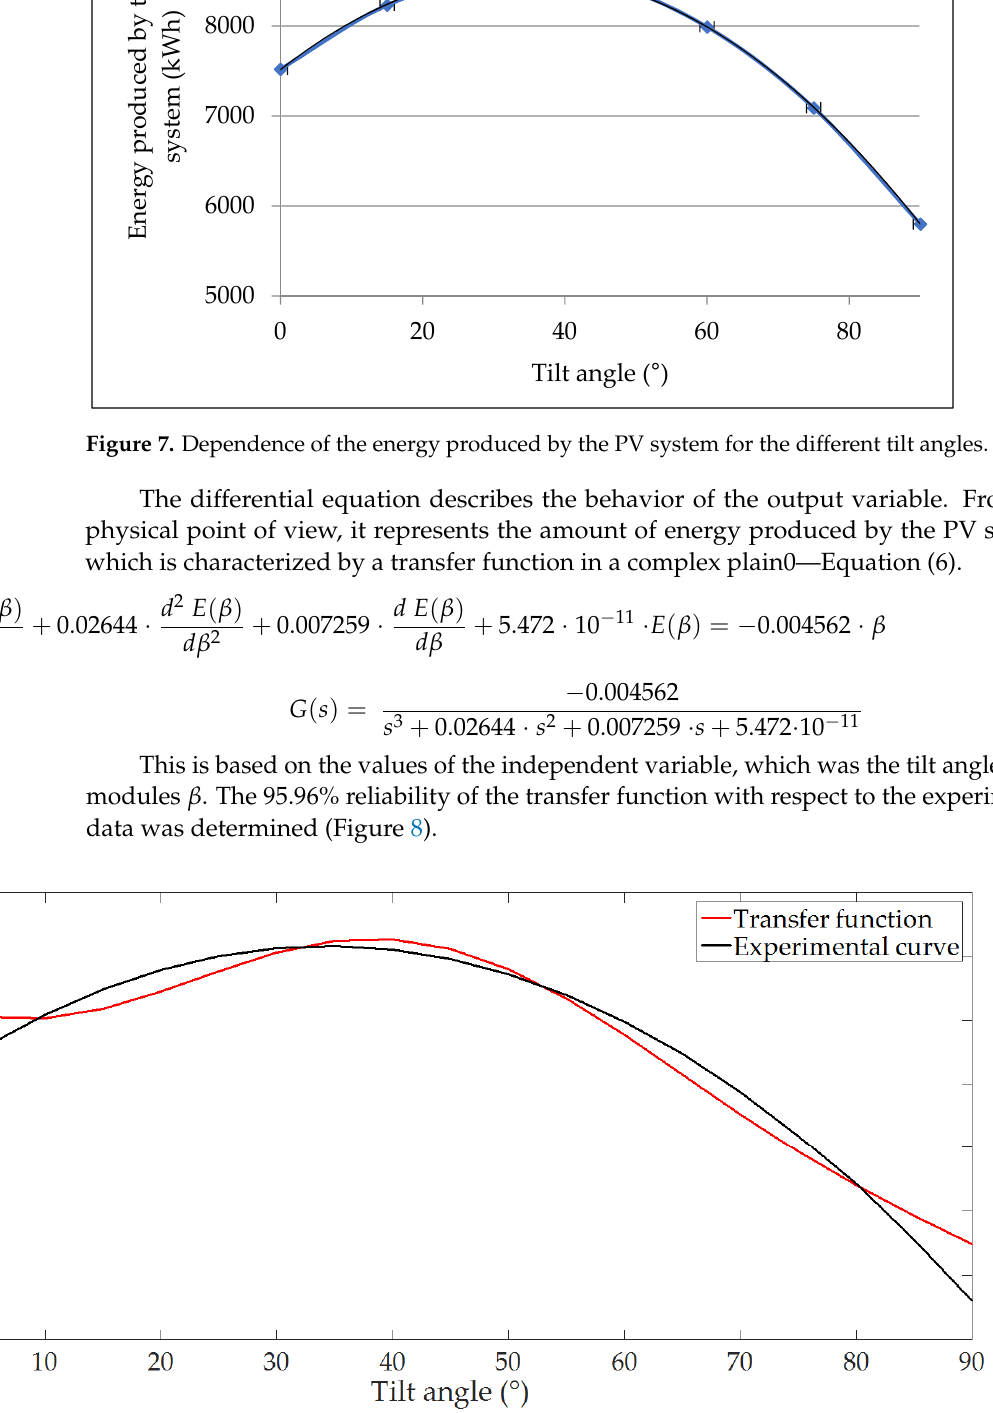
Figure 8. Comparison of the experimental curve and the curve of the analytical model expressed by the transfer function.